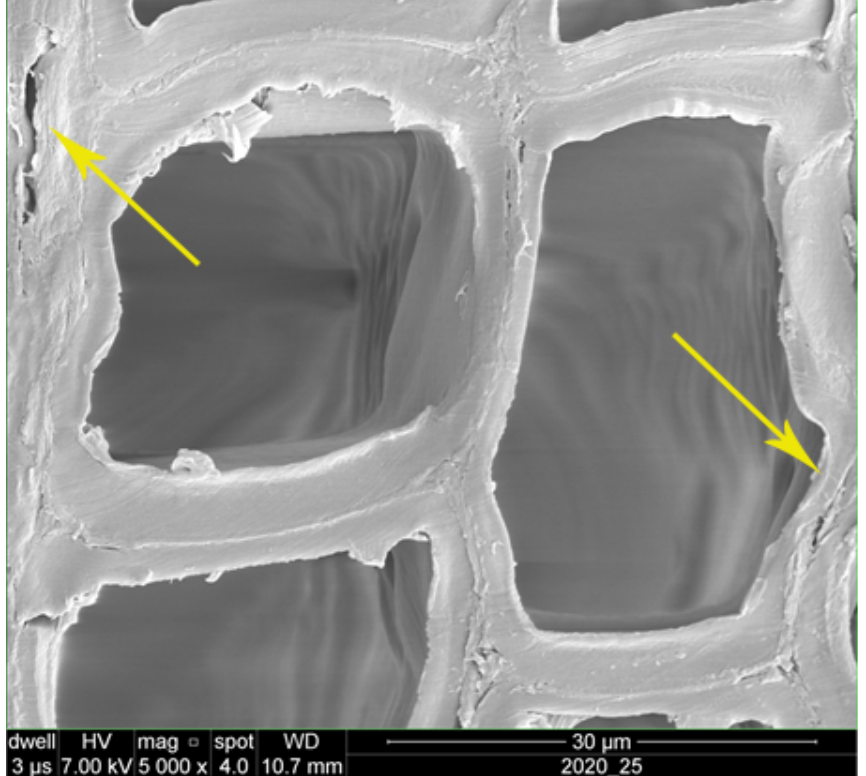
Figure 5. SEM image showing thinned walls and cracks in the cell wall of fir wood ( Abies alba ) heat-treated at 185 °C ( ↑ ).